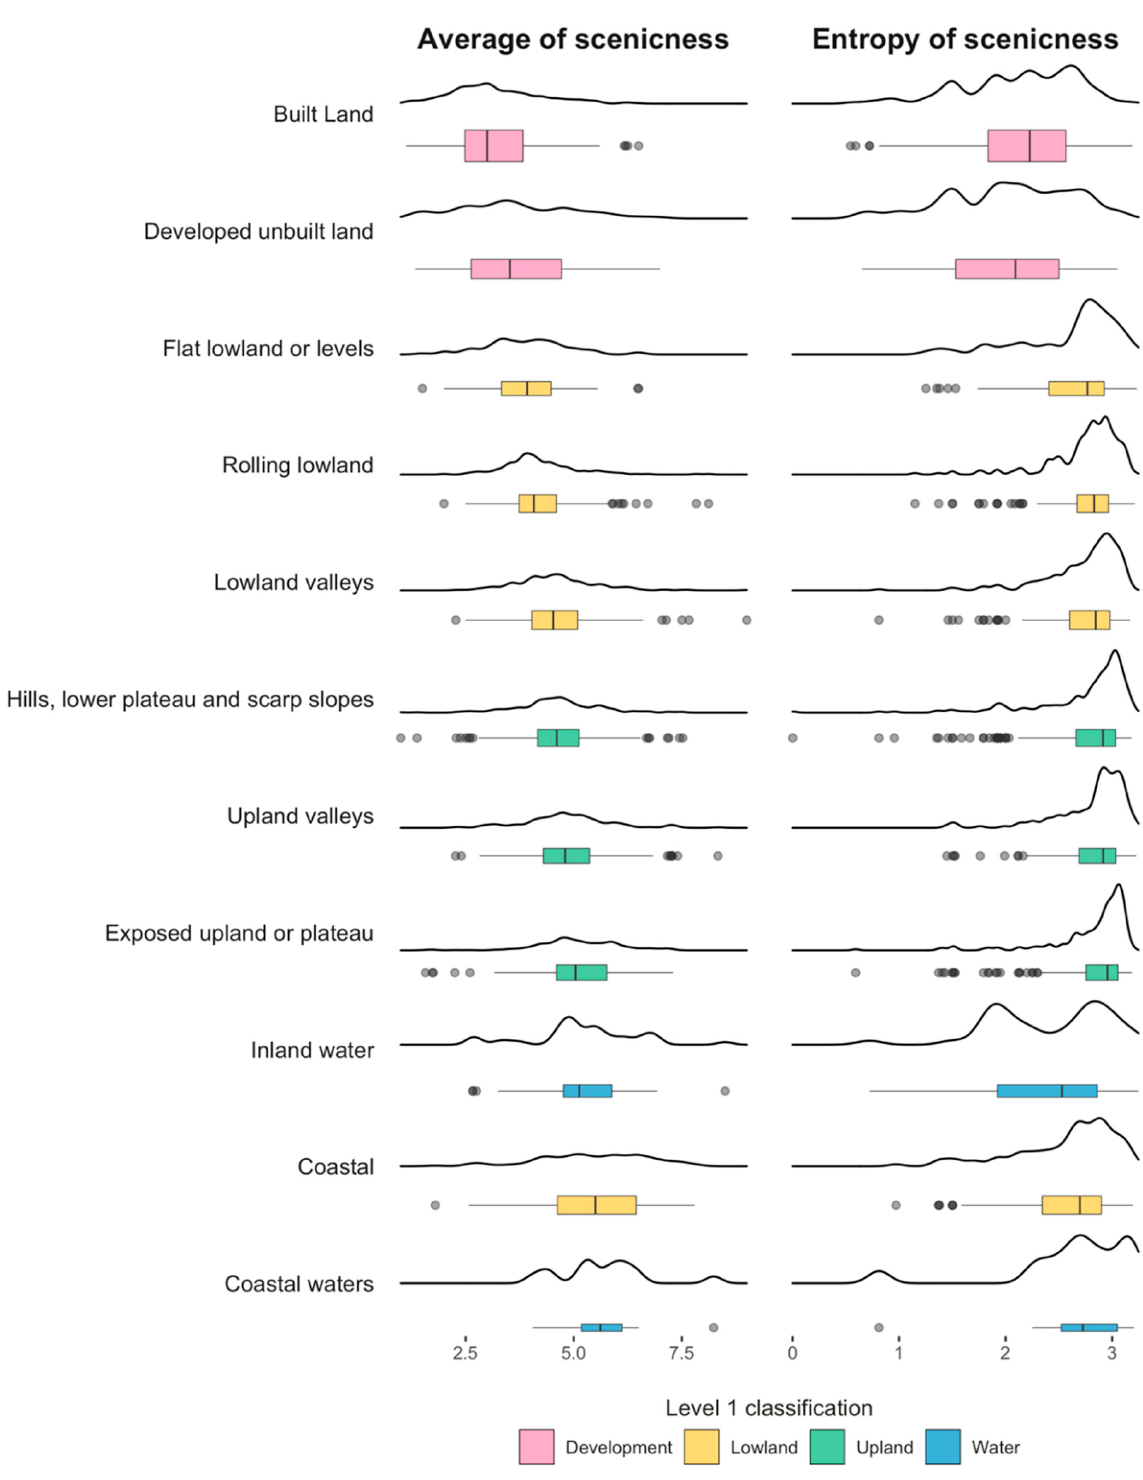
Figure 2. Boxplots of the mean ( left ) and Shannon entropy ( right ) measures of public scenic ratings for each level-2 landform typology show the underlying central tendency and variability of opinions based on the intersected 1716 aspect areas/observations. Shading reflects the root of the hierarchical classification scheme (that is, level-1 typology) and the width of the boxplot is proportional to the sample size.